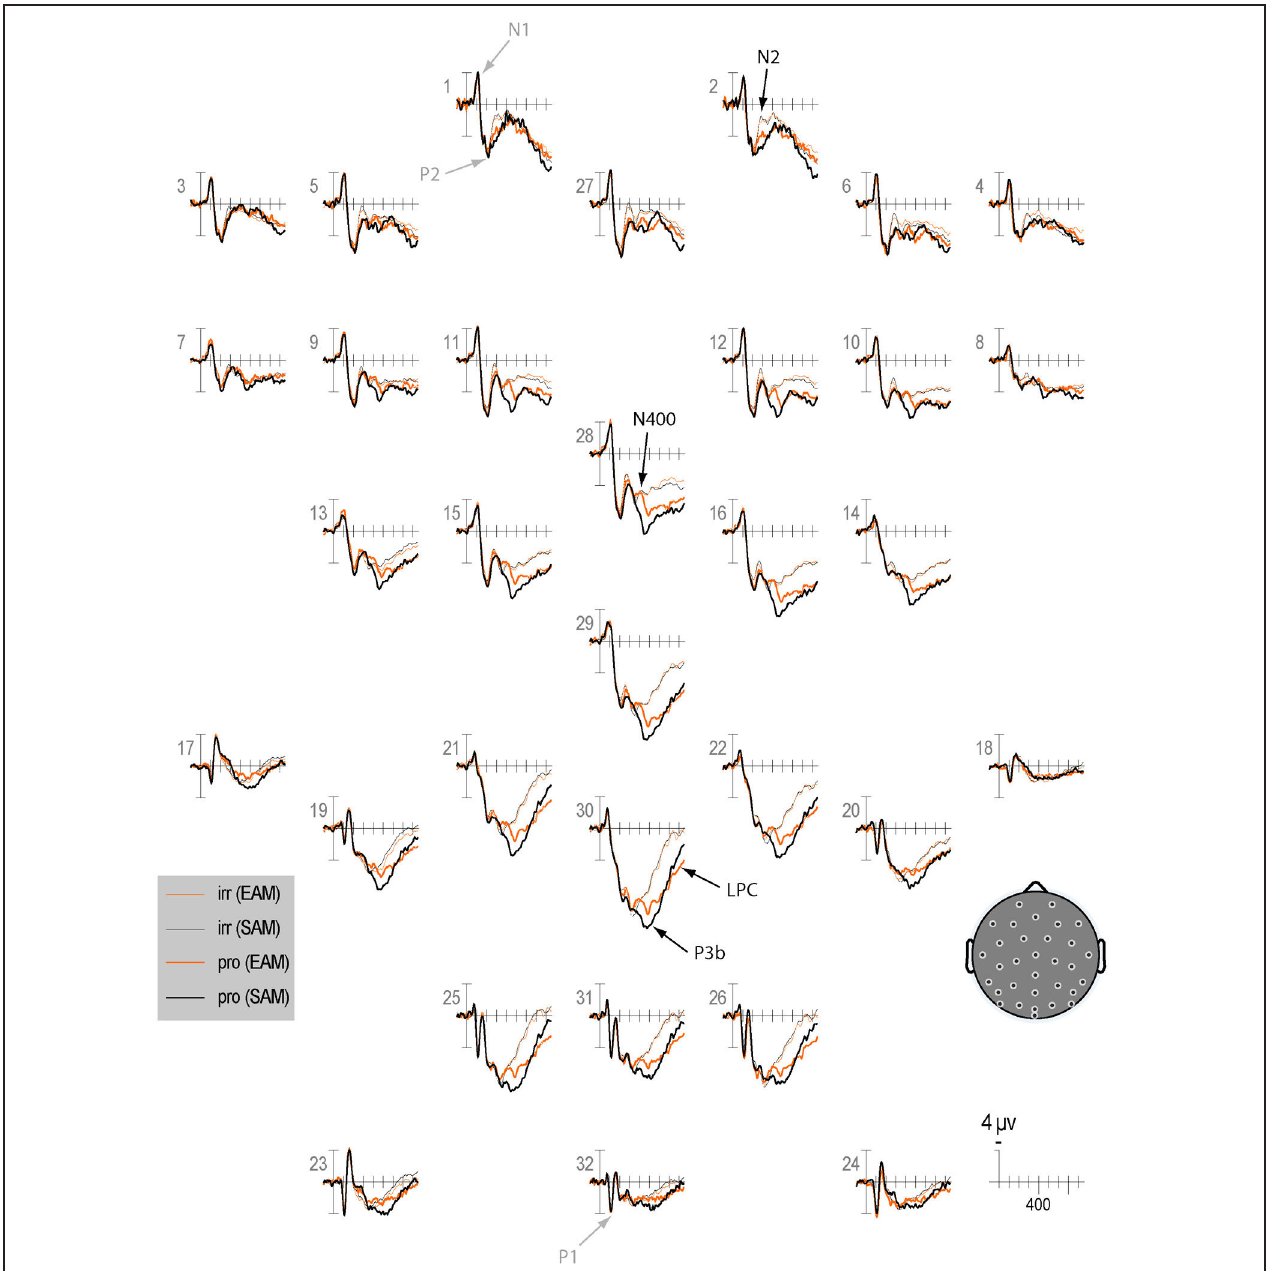
FIGURE 3 | Grand average ERPs elicited by irrelevants (thin solid lines) and probes (thick solid lines) in the semantic (black lines) and episodic (red lines) autobiographical conditions. ERPs are plotted between-100 and